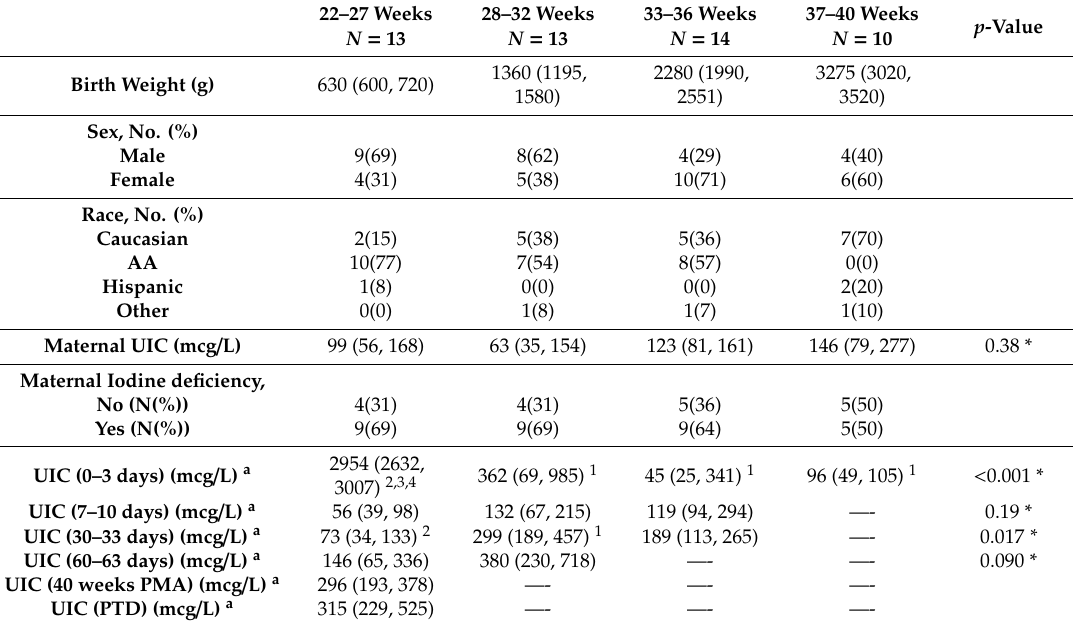
Table 3. Comparison of Iodine levels according to Gestational age